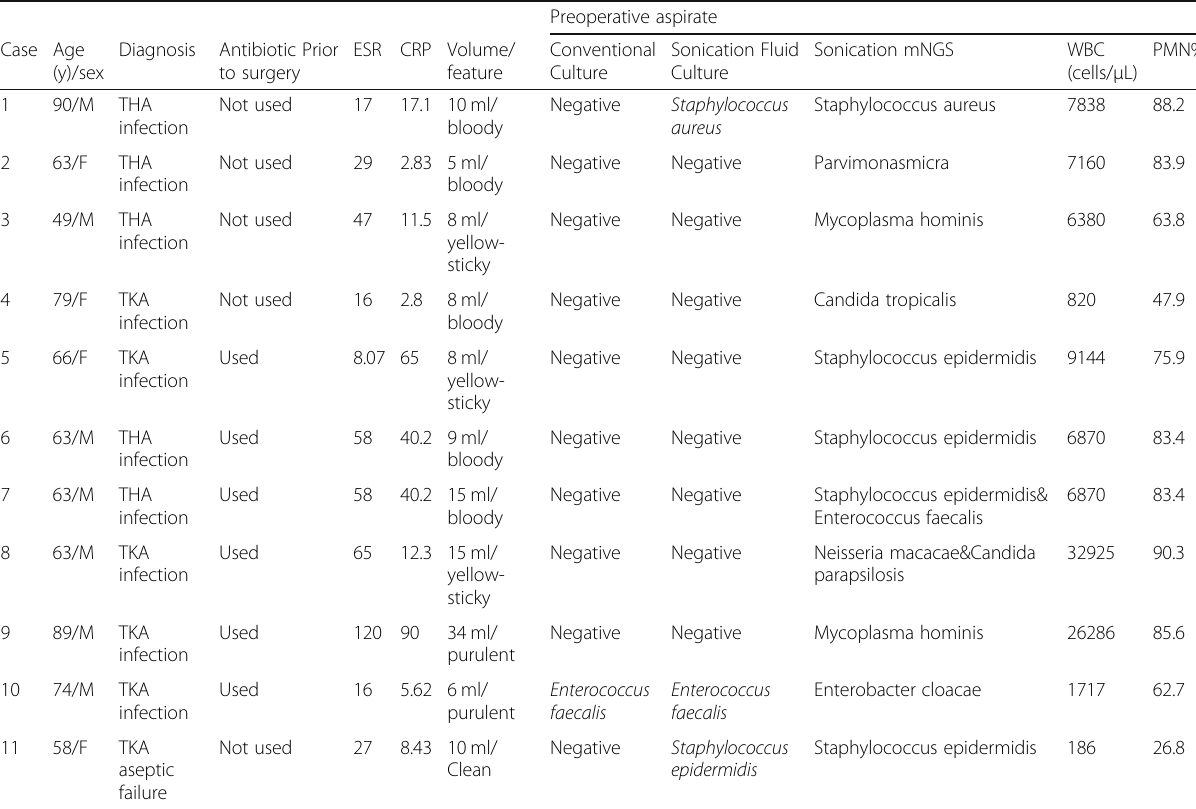
Preoperative aspirate